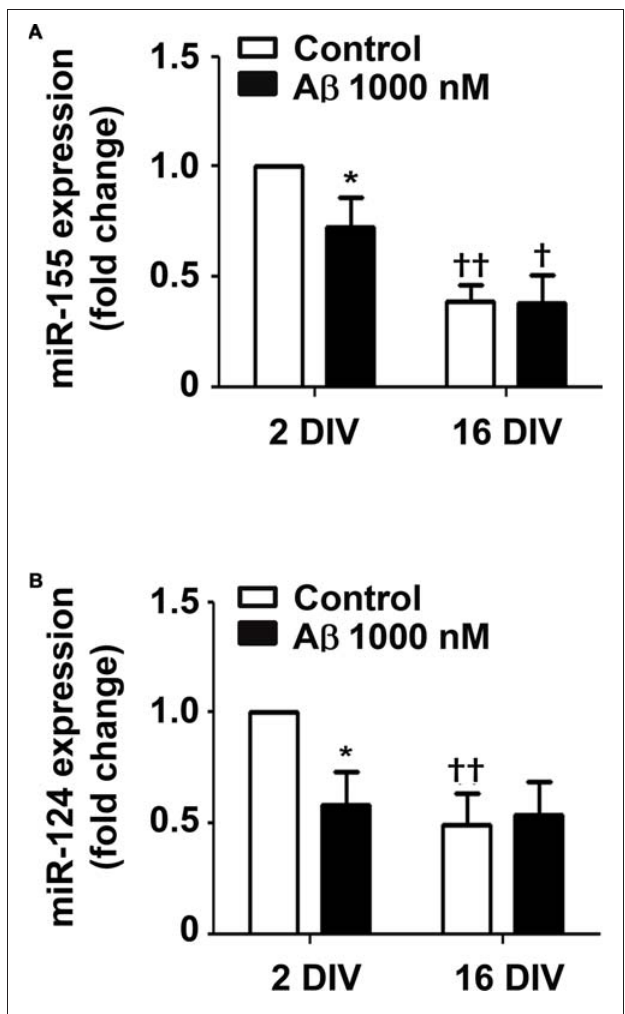
FIGURE 7 | Amyloid- β (A β ) peptide decreases the expression of miRNA (miR)-155 and miR-124 in the reactive cultured microglia toward that of 16 days in vitro (DIV) cells. Microglia that were kept in culture for 2 and 16 DIV were treated with 1000 nM A β for 24 h. (A) Expression of M1/pro-inflammatory-related miR-155 and of (B) M2/anti-inflammatory-related miR-124 was evaluated by Real-Time PCR. Results are expressed in graph bars as mean ± SEM. Cultures, n = 4 per group. Two-way ANOVA ( Post hoc Bonferroni test); ∗ p < 0.05 vs. respective non-treated Control; † p < 0.05 and †† p < 0.01 vs. 2 DIV